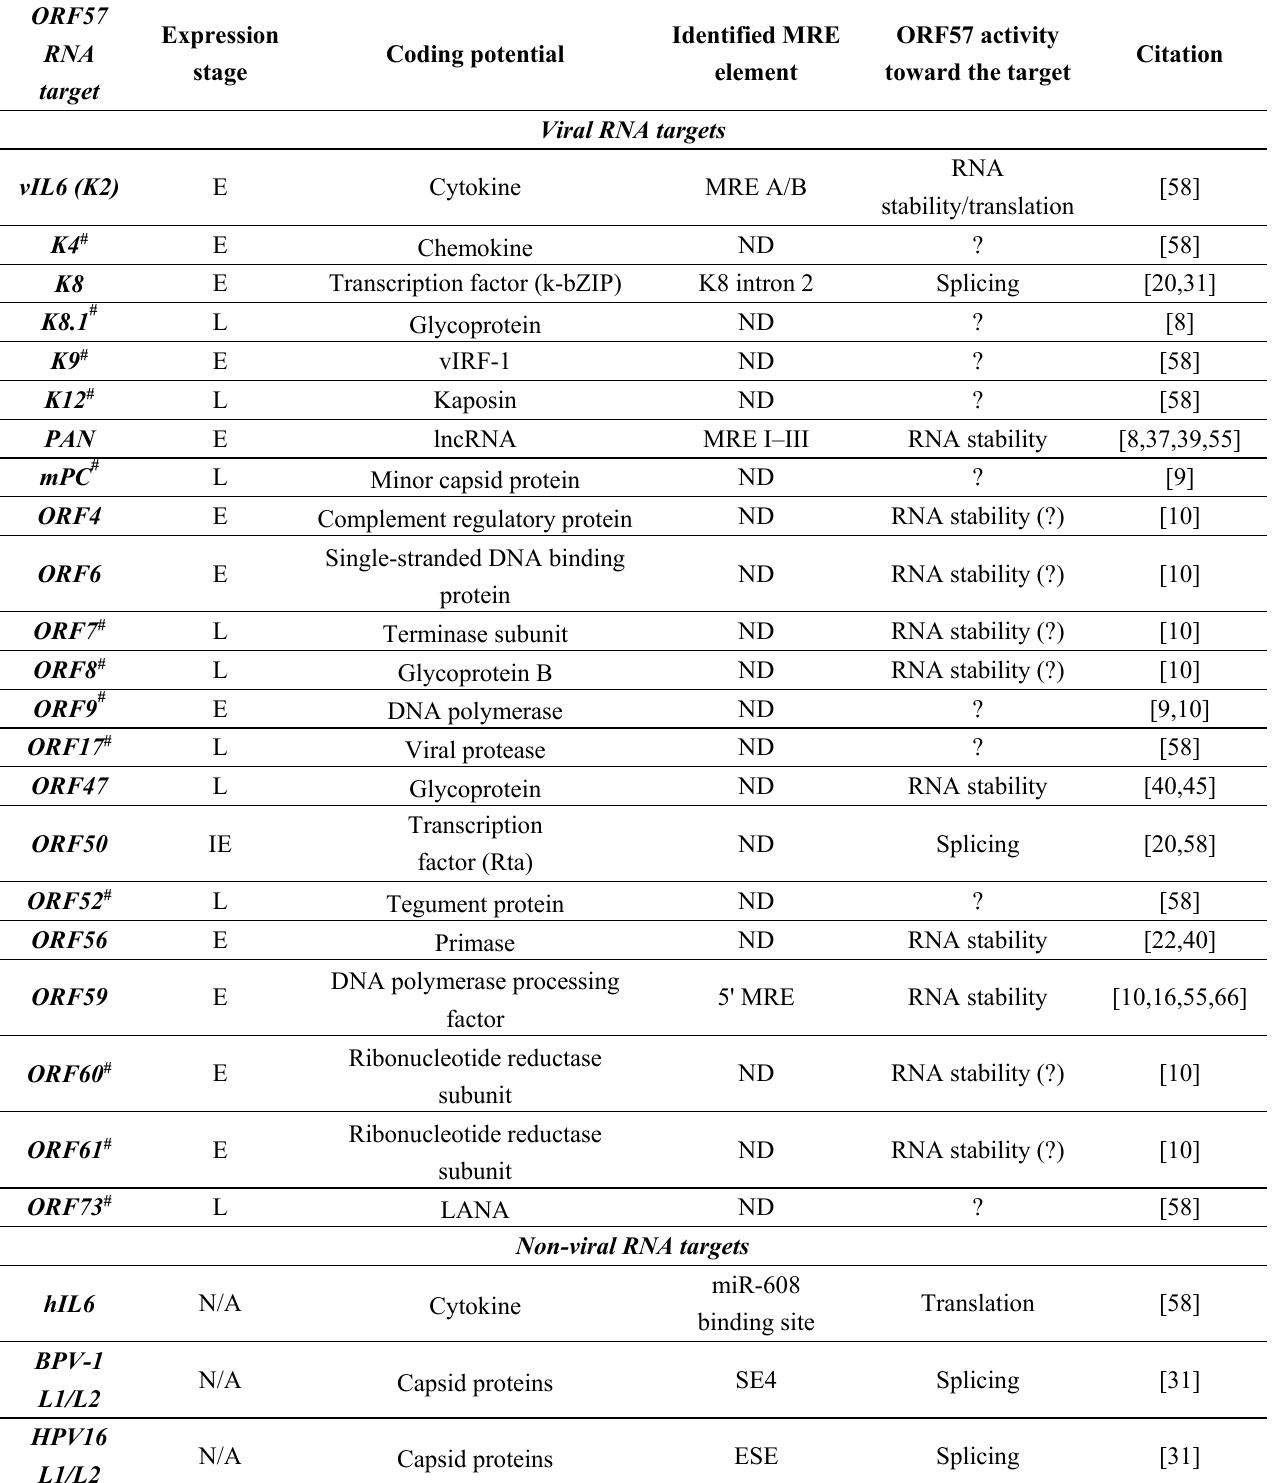
Table 2. Transcripts regulated by